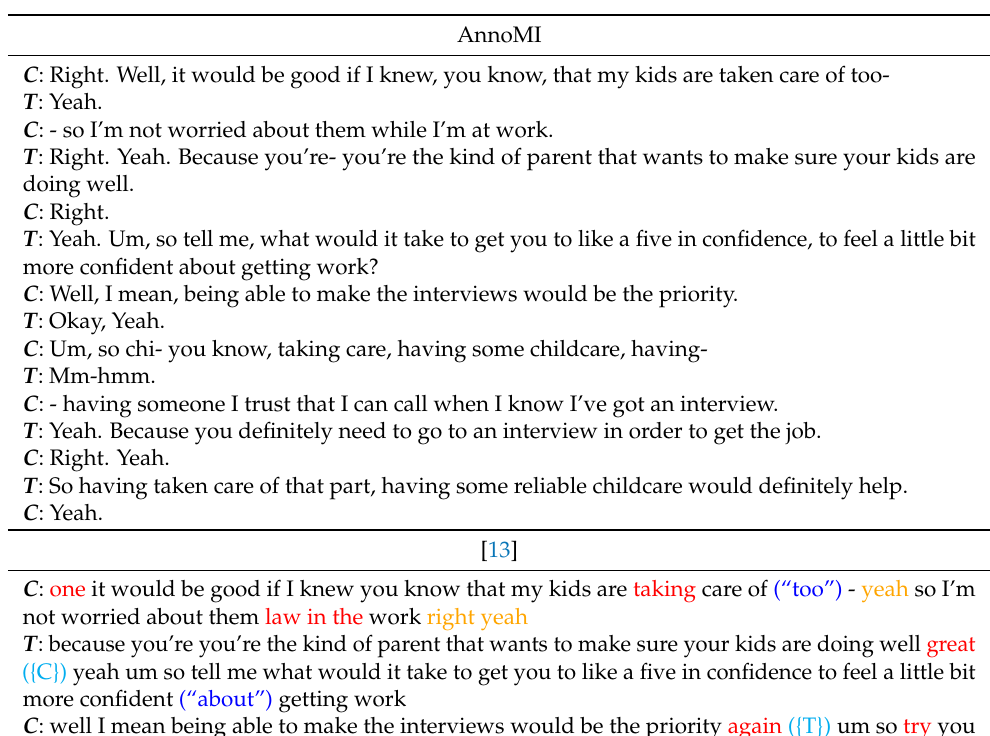
Table 2. Transcription quality comparison between AnnoMI and [13]. Red: incorrectly transcribed word; Blue: omitted words/phrases; Orange: words from the other speaker that should have